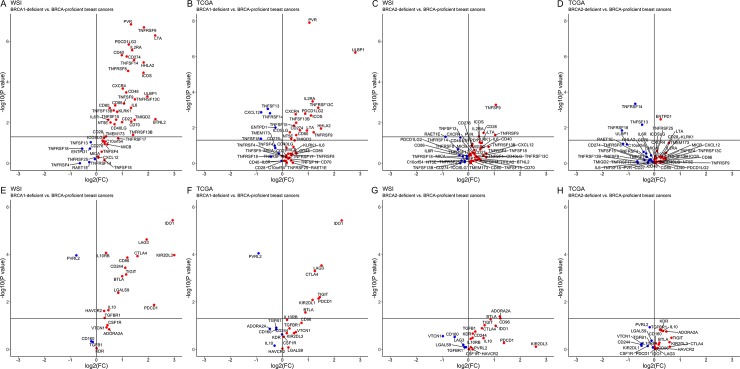
Volcano plots of immunostimulator (A-D) and immunoinhibitor (E-H) molecules in BRCA1- and BRCA2-deficient vs. BRCA-proficient breast cancers from WSI and TCGA. FC: fold change. KIR2DL3 with log2FC 14.5 in BRCA1-deficient vs. BRCA-proficient breast cancers from WSI shown at the boundary of the plot.